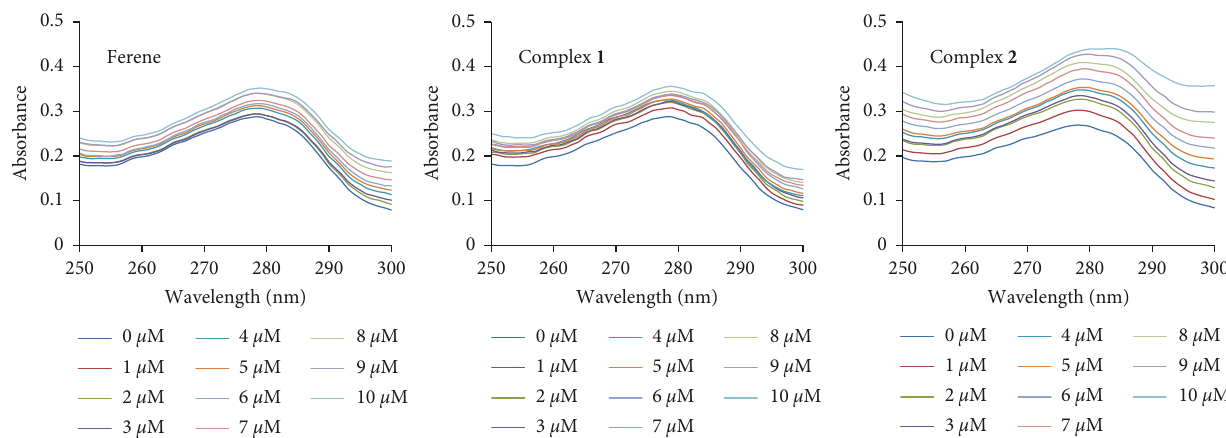
Figure 5: Absorbance spectra of BSA in the presence of different concentrations of ferene, complex 1 , and complex 2 .